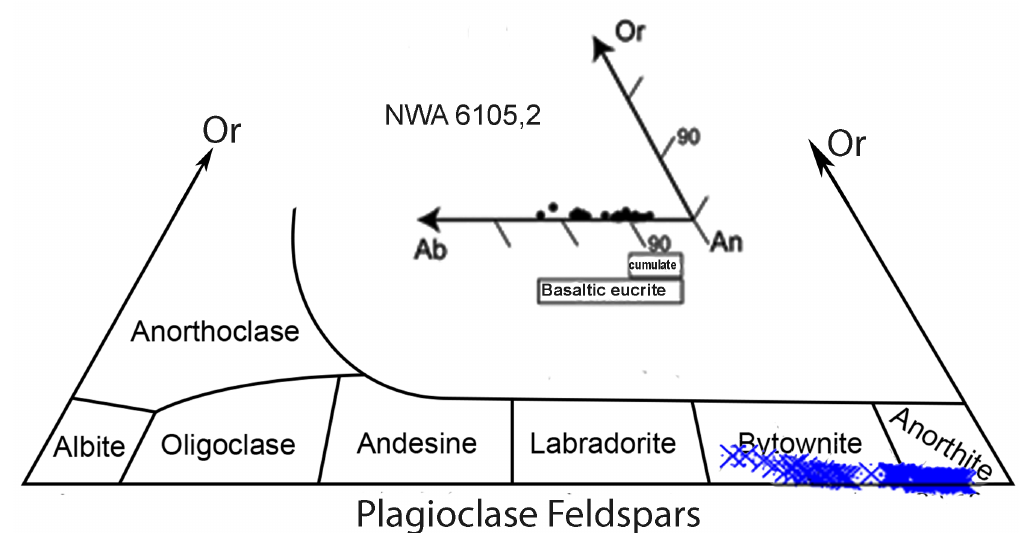
Figure 6 - An-Ab-Or ternary diagram depicting the plagioclase compositions in Serra Pelada compared with NWA 6105,2 (McSween et al. 2011).